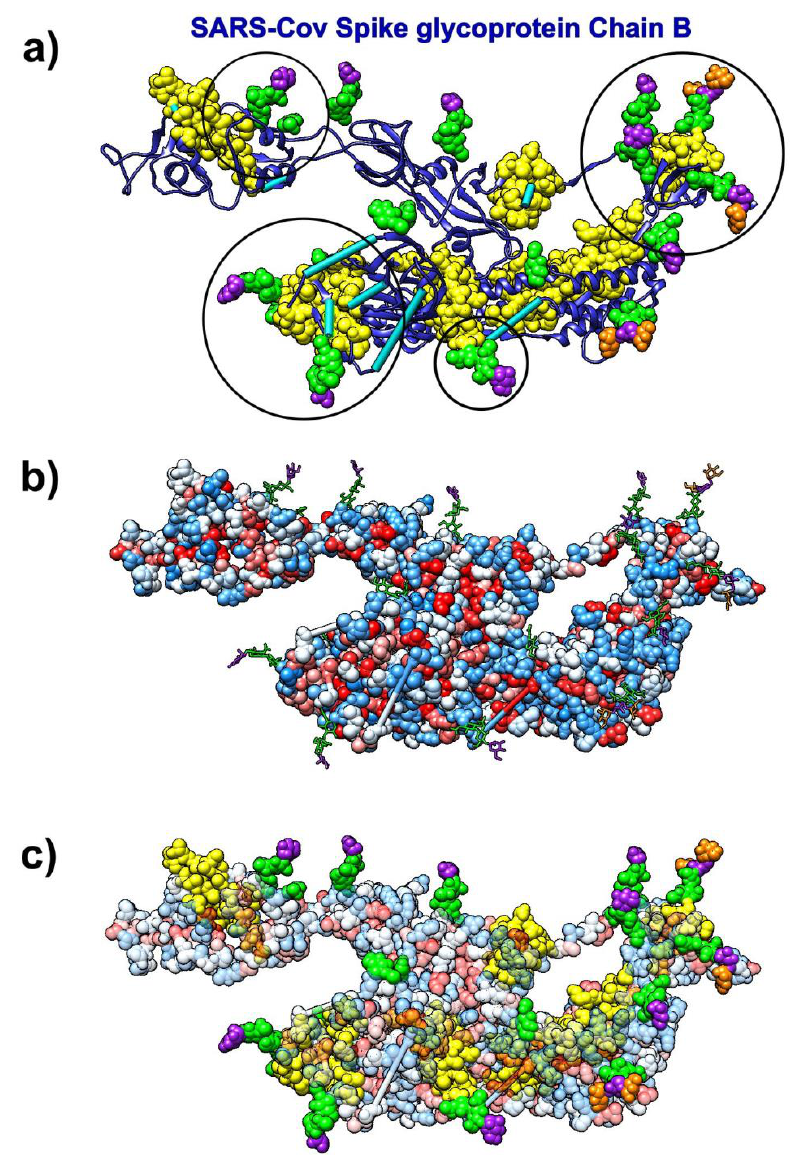
Figure 9. SARS-CoV spike glycoprotein (Chain B, pdb id 6nb6) with glycans (NAG, BMA, MAN) bound to it. ( a ) Ribbon-like representation of SARS spike glycoprotein. The SAGNM predictions are yellow atoms. BMA molecules are represented via purple atoms. MAN molecules are represented via orange atoms. NAG molecules are represented via green atoms. Cyan bars represent missing glycoprotein segments. Circles represent areas where the SAGNM predictions recognize real binding spots. ( b ) SARS spike glycoprotein is depicted via hydrophobicity colored atoms. Glycans (NAG, BMA, MAN) are represented via colored bonds (same colors as above). ( c ) SARS spike glycoprotein is depicted via transparent hydrophobicity colored atoms. Glycans (NAG, BMA, MAN) are represented via colored bonds (same colors as above). The SAGNM predictions are yellow atoms. Glycans (NAG, BMA, MAN) are represented via colored atoms. We also analyzed the distribution of SAGNM recognized residues in the structure formed by the SARS spike glycoprotein RBD and the human neutralizing S230 antigen-binding fragment (FAB)